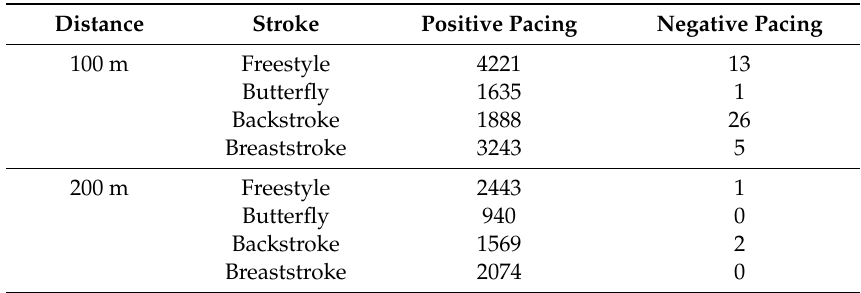
Table 1. Number of athletes adopting a positive or negative pacing in 100m and 200m swim races in the four strokes. Distance Stroke Positive